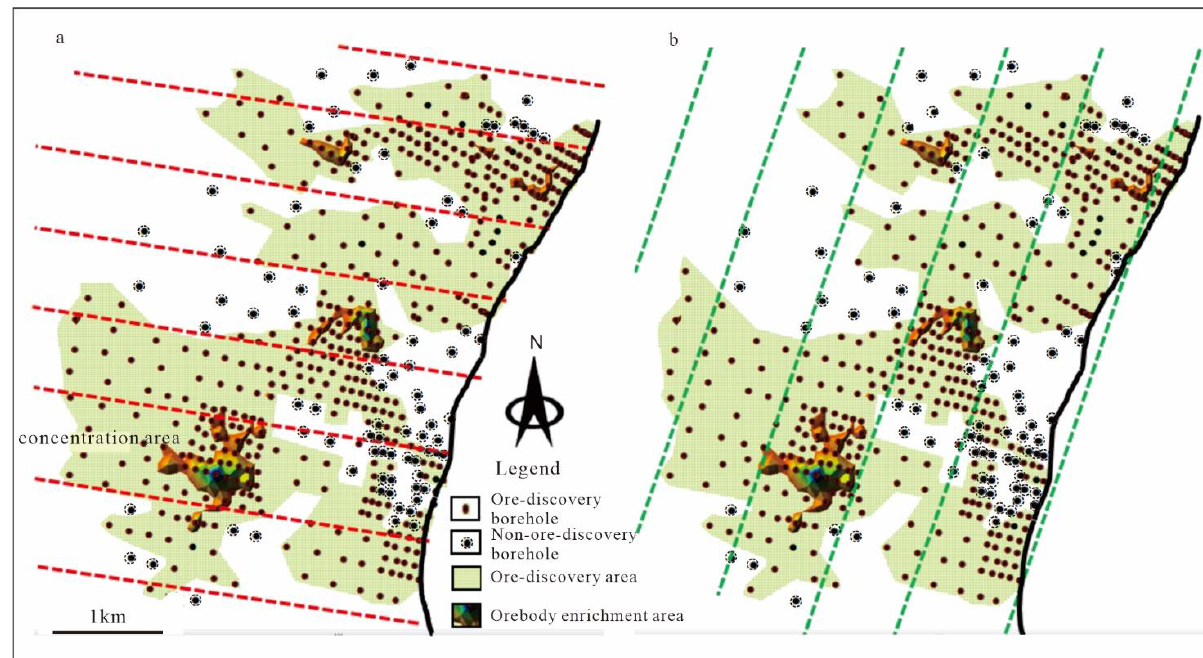
Figure 4. Horizontal projection of orebodies along fault strikes ( a ) and dip directions ( b ) in the Jiaojia deposit concentration area. The red dotted line in figure ( a ) and the green dotted line in figure ( b ) show the equally spaced distribution of orebody enrich areas.